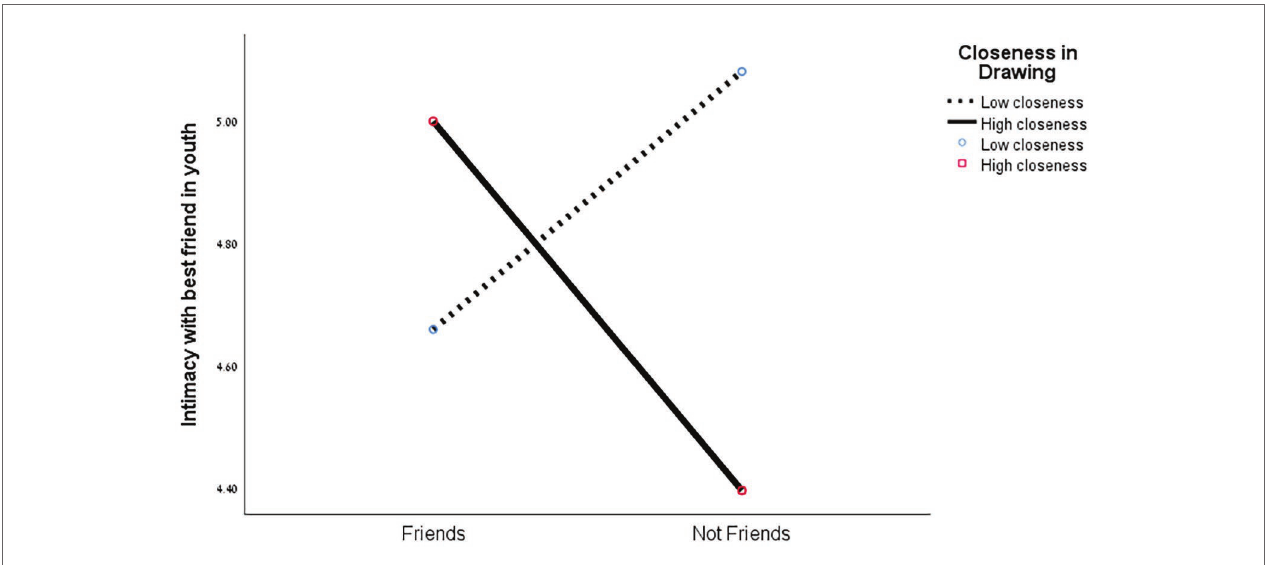
FIGURE 7 | Intimacy with best friend in adolescence and closeness in